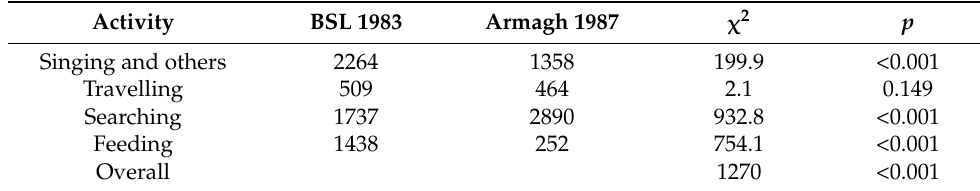
Table 5. Two-way frequency table of bird activity observations. Row-wise tests compare specific activities between two sites.